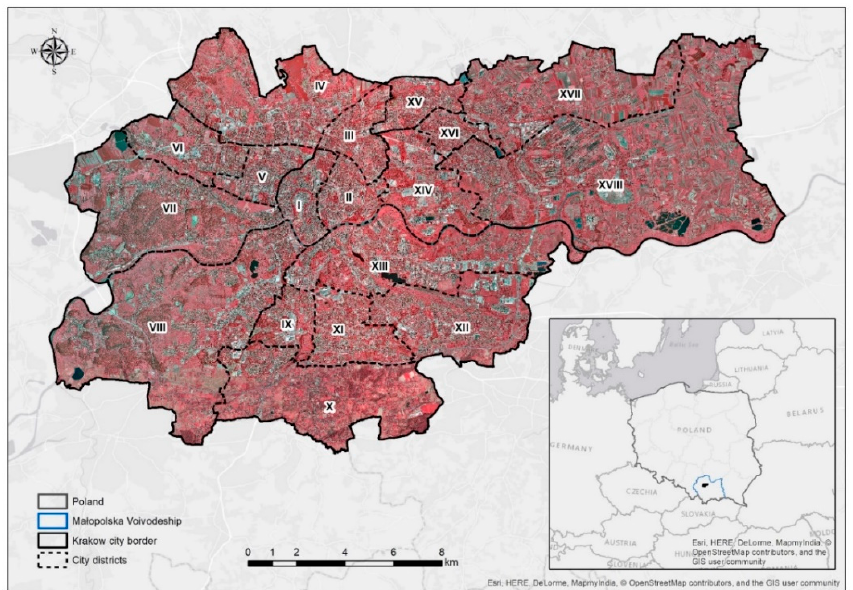
Figure 1. Location of the study area on the base map of Europe and aerial orthophoto (CIR) of the Krakow municipality with district borders.